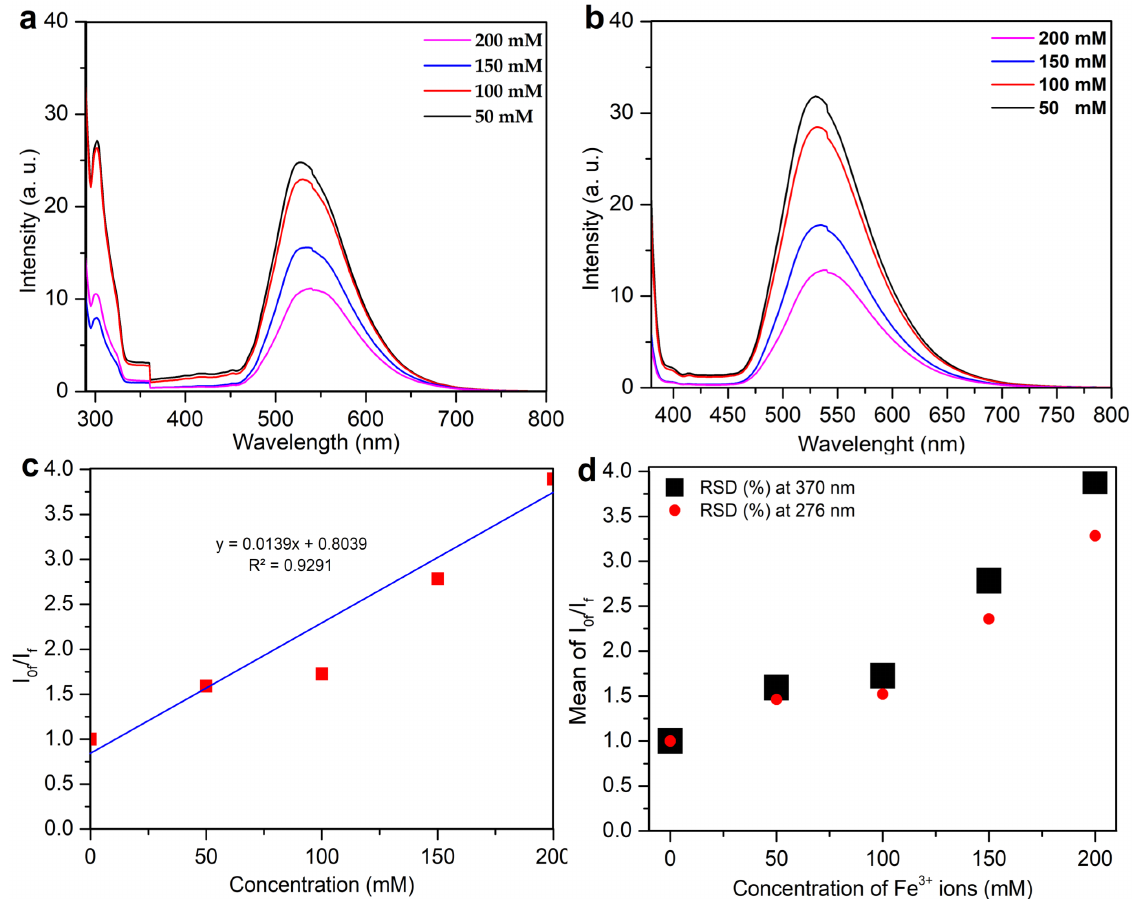
Figure 5: Effect of Fe 3+ concentrations on the emission spectra changes of SBA-15/APTES-NH at (a) 276 and (b) 370 nm and (c) Stern-Volmer plot (wavelength excitation at 370 nm) between relative emission intensity at 533 nm as well as (d) changes in emission intensity with variation concentration of Fe 3+ ions at 276 and 370 nm with SD error bars.